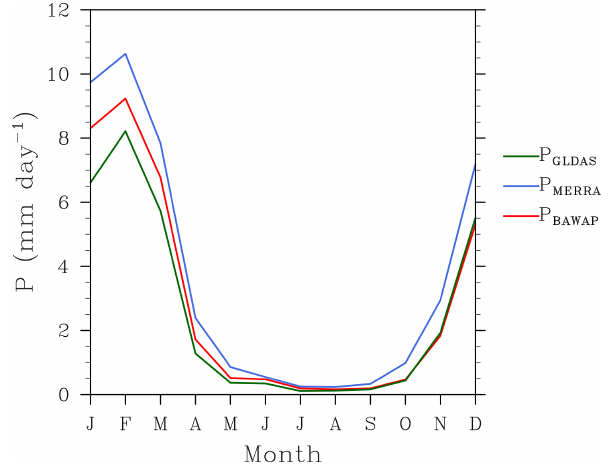
Figure 1. Observations of the (18–11 ◦ S, 120–150 ◦ E) domain- averaged mean annual cycle of precipitation ( P in mmday − 1